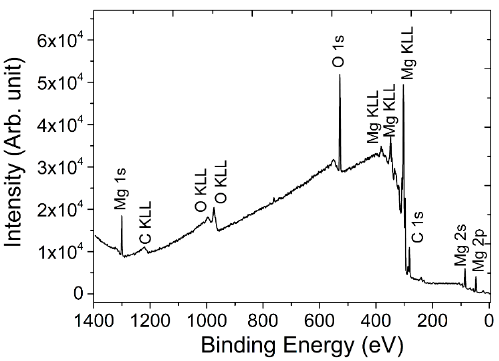
Figure 2. XPS survey spectra of a dense Mg film prepared for α = 0° and P Tot = 0.26 Pa. The sputtering power is 50 W. Table 1. Elemental composition of the as-deposited Mg thin film before and after 2 min of erosion. At.% Mg At.% O At.% C At.% Mg At.% O